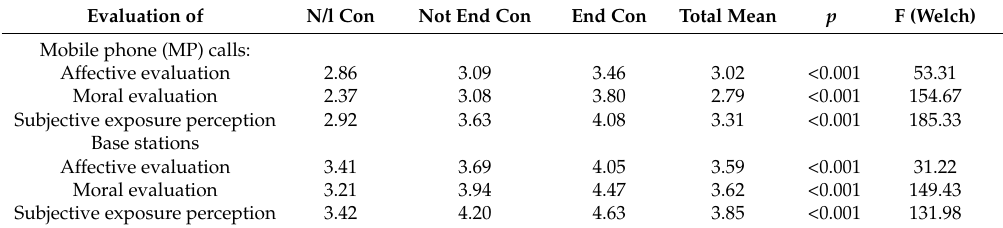
Table 3. Means and analysis of variances of affective and moral evaluation, subjective exposure perception of base stations and mobile phones per group (n/l con = not and less concerned; not end, co n = not enduringly concerned; endcon = enduringly concerned), on 5–point Likert scale from 1 = “Very positive”, to 5 = “Very negative” for affective evaluation; from 1 = “Not at all”, to 5 = “Yes absolutely” for moral evaluation; from 1 = “Low”, to 5 = “High” for exposure